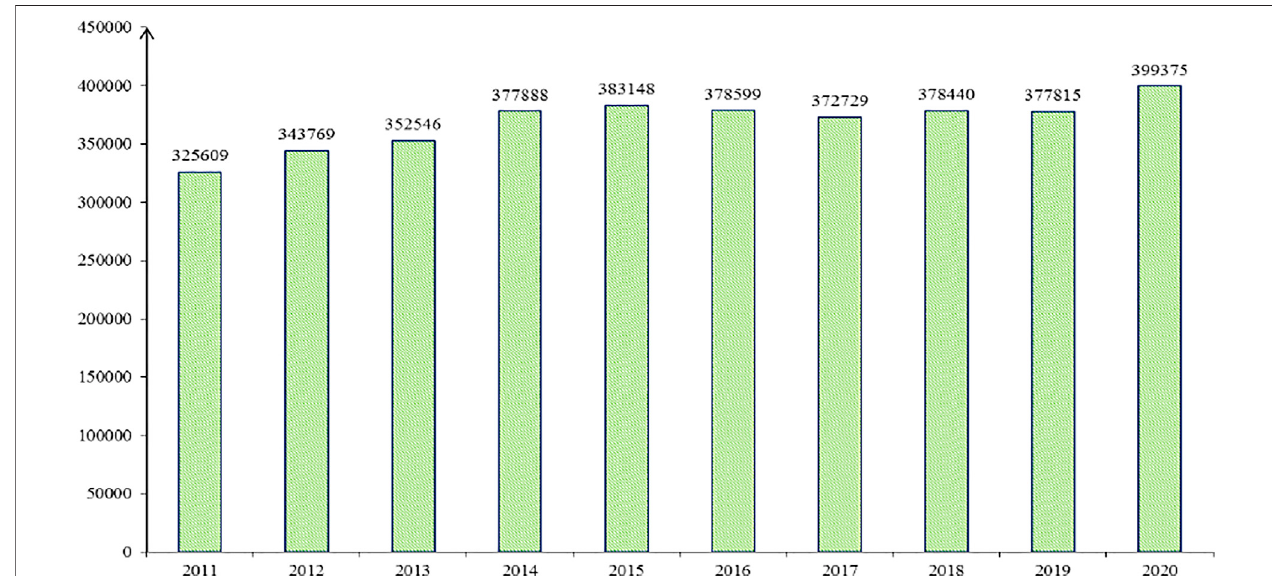
FIGURE 1 | Numbers of industrial enterprises above designated size in China during 2011 – 2020 (unit). Source: The author searched for the information from the China Statistical Yearbook (2012 – 2021). Note: According to the brief introduction from the China Statistical Yearbook 2021, data of main indicators of industrial enterprisesabovedesignatedsizearenotcomparablewithpreviousyearssince2017basedonmanyreasons.Hence,this fi gureonlyprovidedroughlyatrendaboutthe numbers of these enterprises, which was what this study needed.